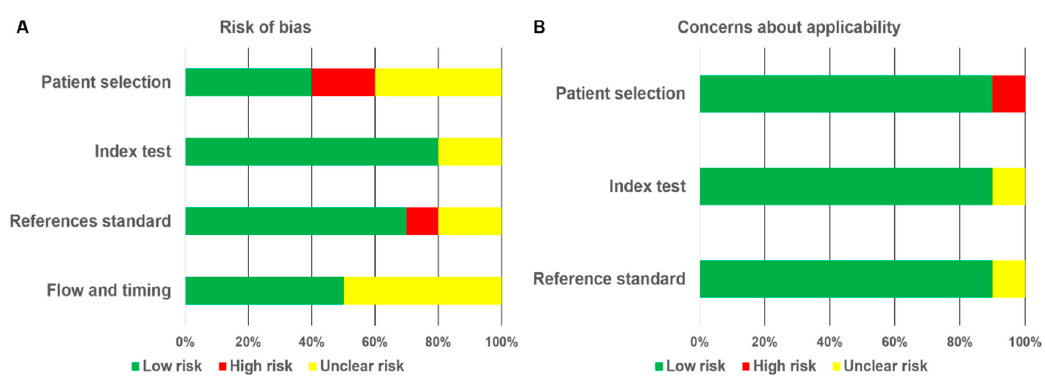
Figure 2. Quality assessment of 10 included studies using the QUADAS-2 tool to evaluate the risk of bias ( A ) and concerns about applicability ( B ). Each diagram shows the percentage of studies with low (green), high (red), and unclear (yellow) risk of bias.